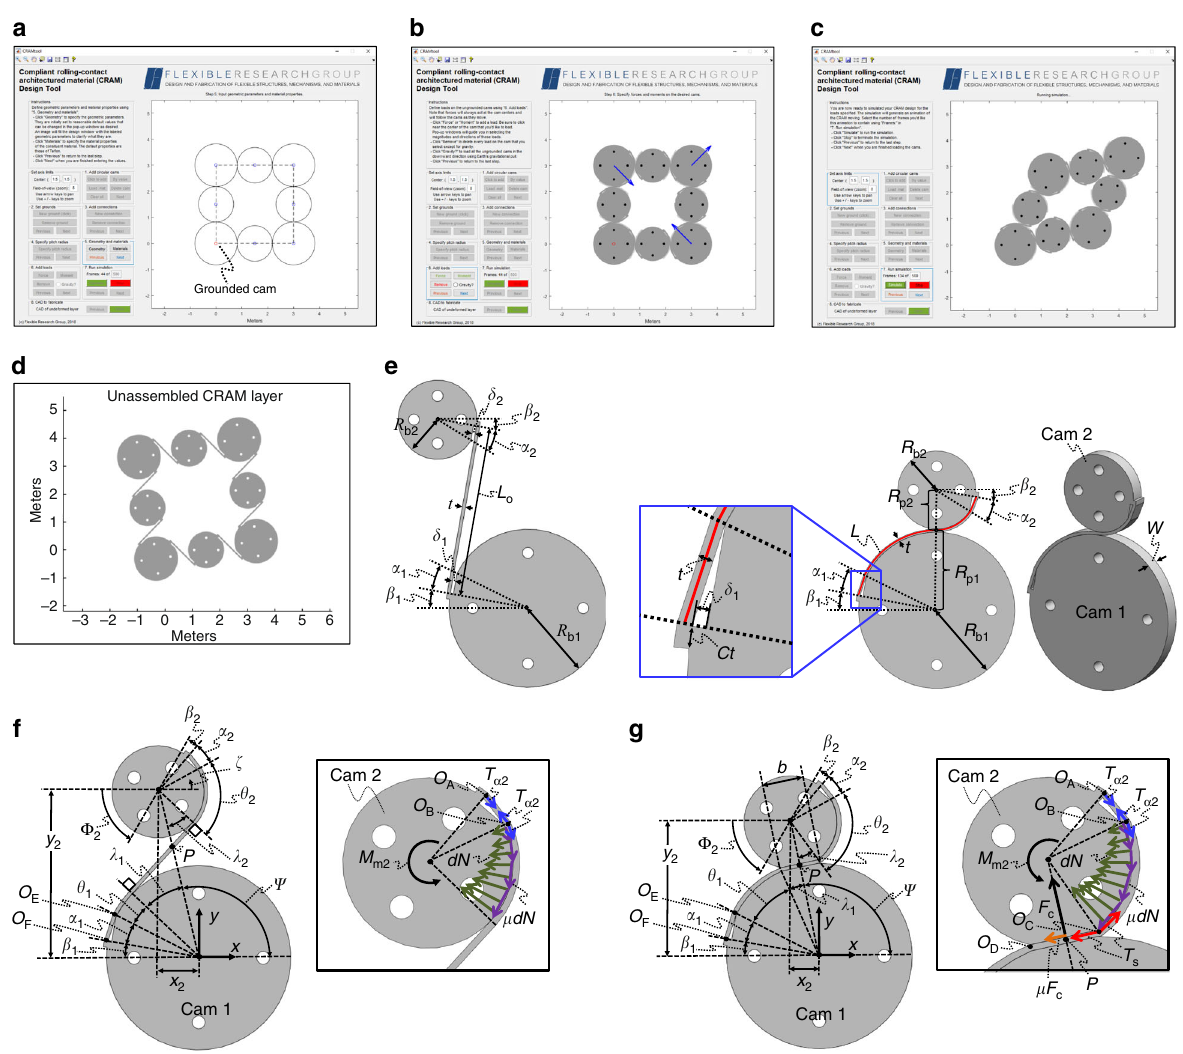
Fig. 5 Software design tool enabled by the compliant rolling-contact joint (CRJ) modeling theory. a Cam locations, connections, and radii are speci fi ed by the user in the tool ’ s design window. b Loads are de fi ned. c The design is simulated. d Its unassembled layer geometry is given. e Geometric parameters that de fi ne a single CRJ layer. Parameters that de fi ne the strap loads imparted on CRJ cams for general f tension and g compression